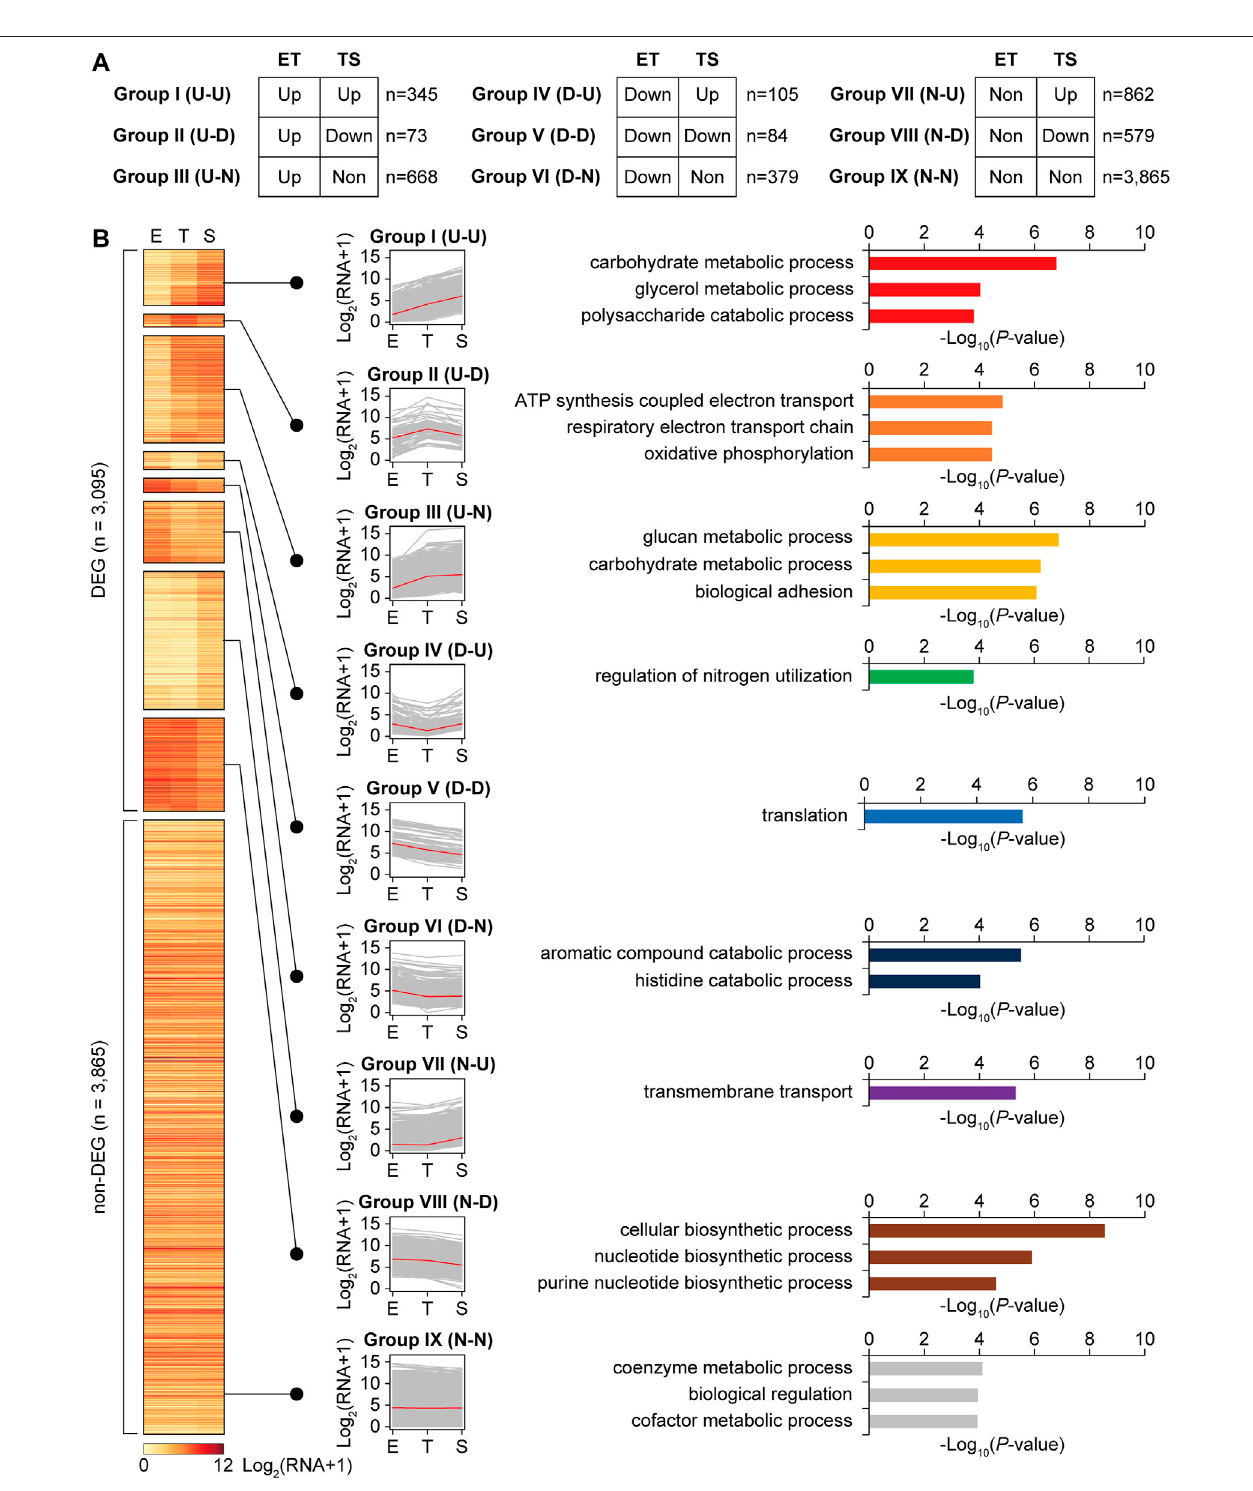
FIGURE2| Clusteringoftotalgenesaccordingtothetranscriptionlevelpatternsduringgrowth,andenrichedgenefunctionsofeachclustergroup. (A) Total6,960 genesweredividedintodifferentiallyexpressedgenes(DEGs,|log 2 foldchangebetweenEandT,orTandSphases| > 1, p < 0.05byDESeq2),andnon-DEGs(groupIX). Further, DEGs were subdivided into eight transcription pattern groups according to their expression patterns. ‘ ET ’ and ‘ TS ’ indicate gene expressions at T phase compared to E phase, and at S phase compared to T phase, respectively. ‘ U ’ , ‘ D ’ , and ‘ N ’ indicate upregulated, down-regulated, and no signi fi cant change, respectively. (B) Aheatmapoftranscriptionlevelpatternsofatotal6,960genes,transcriptionpatternlinegraphsofeachgroup,andthefunctionalenrichmentofgenesin each group. Red line in the line graph is the median of transcription level among the genes. Selected enriched gene functions of each group were represented with their − log 10 p -value (GO-term enrichment, GO_Biological_Processes, hypergeometric test, Benjamini and Hochberg False Discovery Rate (FDR) correction ( q